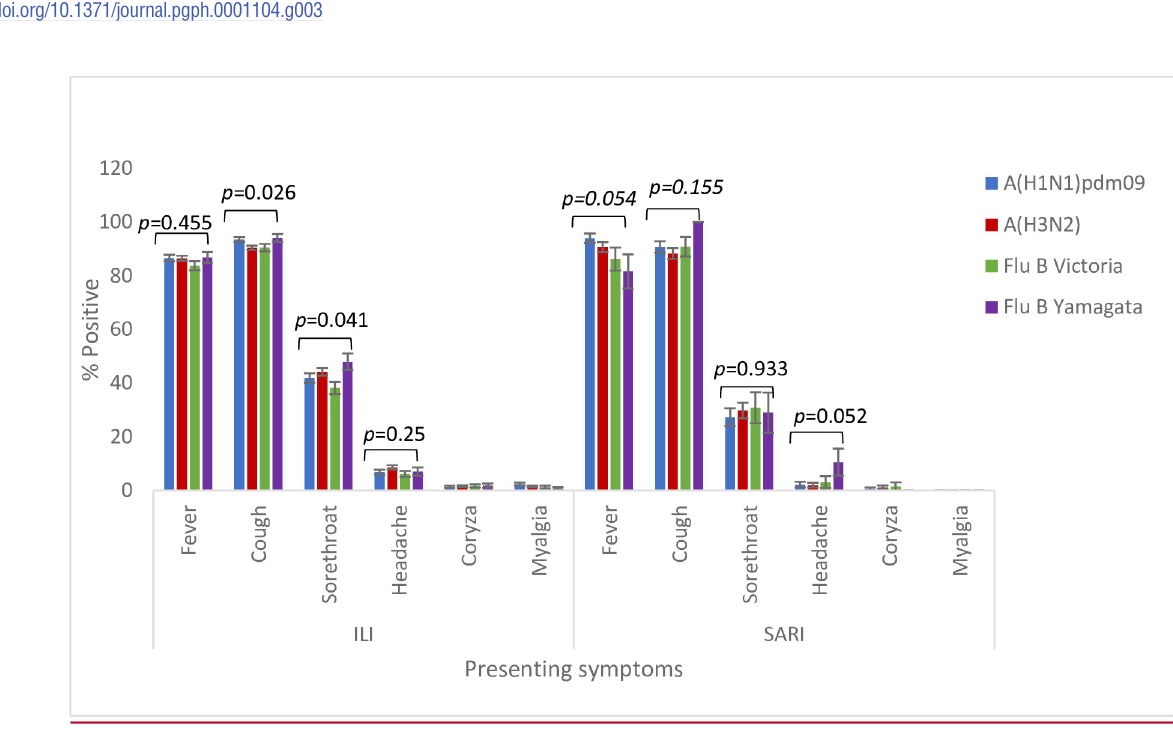
PLOS Global PublicHealth | https://doi.org/10.1371/journal.pgph.0001104 December 9, 2022 8 /